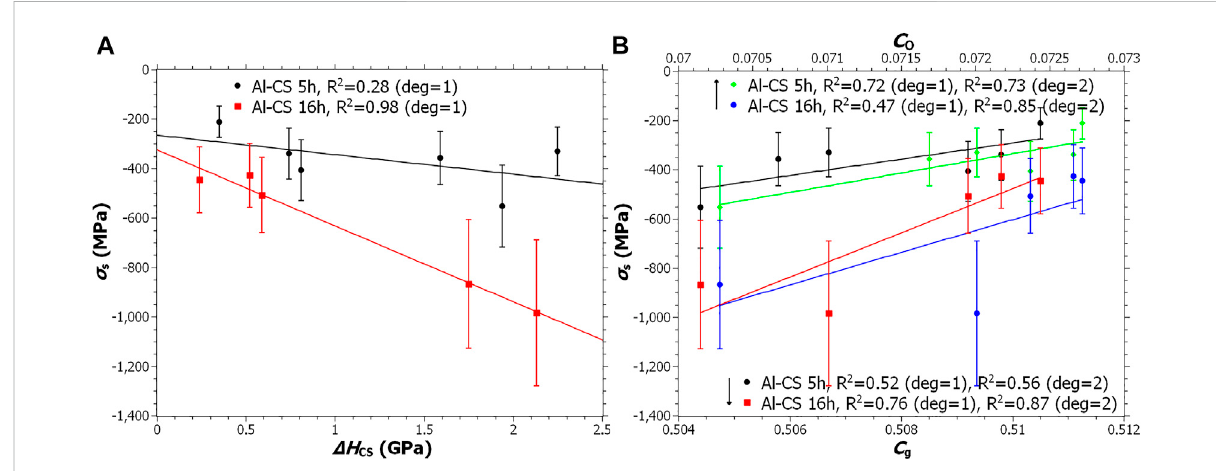
FIGURE 9 Residual compressive stress (RCS) at surface, σ s, as a function of (A) Δ H CS and (B) C g as well as C O